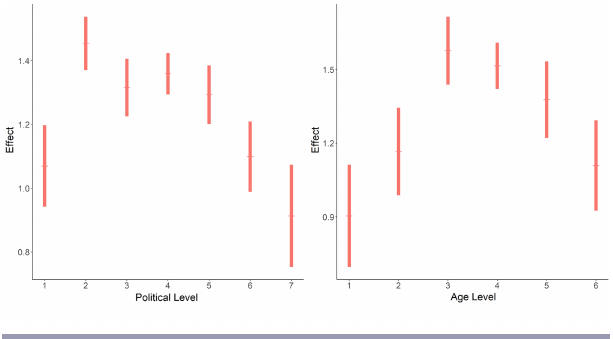
Fig. 2 . Group-wise preference for ground-based deployment with 95% confidence